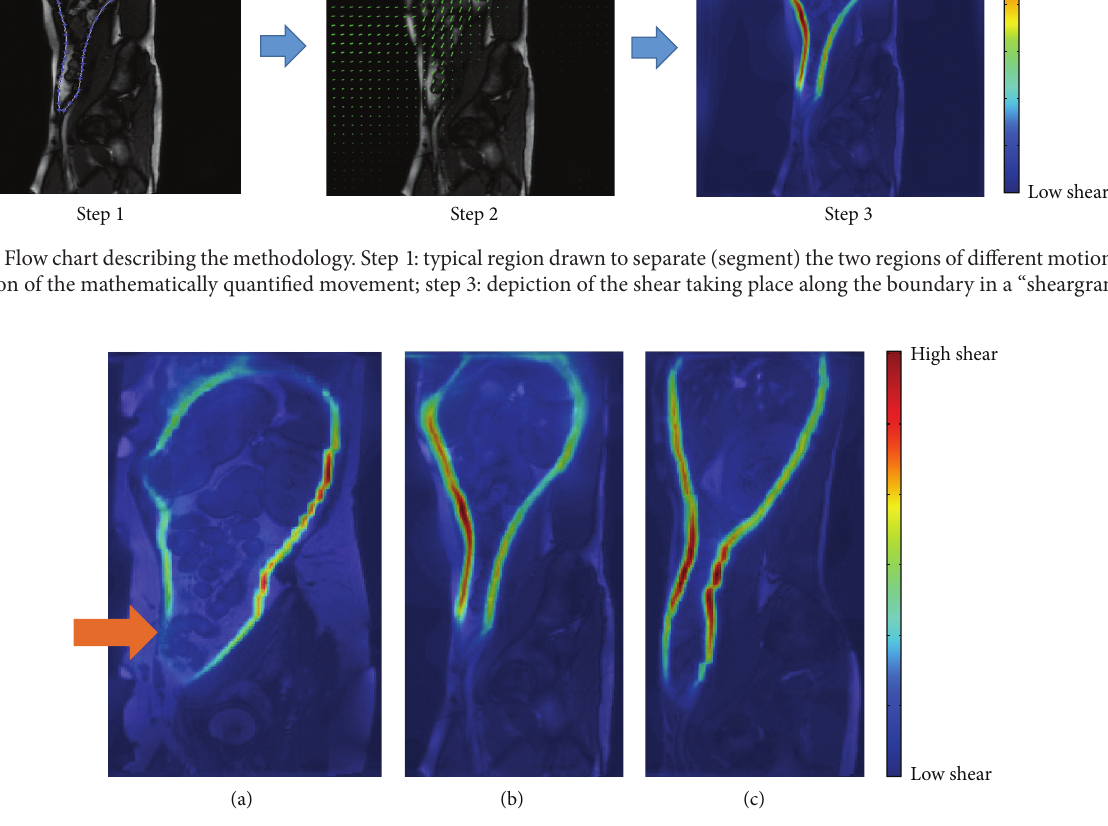
Figure 3: Comparison of the sheargrams from (a) a patient with an adhesion (arrow) and (b) and (c) two healthy